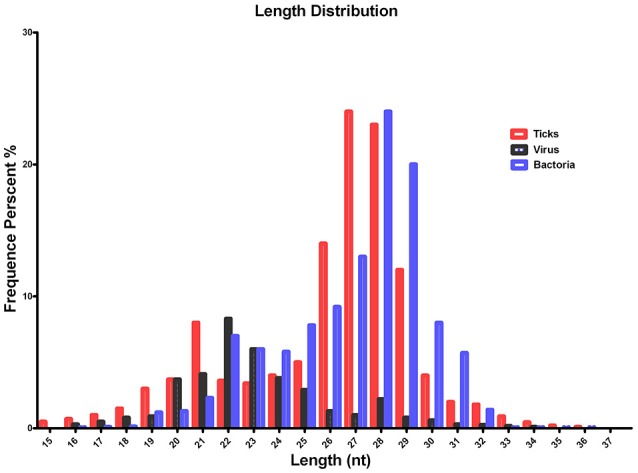
Summary of the tag length distribution following the sequencing and annotation of small RNA from Hyalomma rufipes. The length of the small RNAs varied between 18 and 30 nt. Length distribution analysis is helpful when elucidating the composition of small RNA samples. For example, miRNA is normally 21 or 22 nt, siRNA is 24 nt, and piRNA is 30 nt. The x-axis represents the length of the small RNAs. The y-axis represents the percentage frequency of small RNAs of specific lengths among the sequencing reads. Red indicates the length distribution of total clean reads from ticks and the first peak generated by the Dicer enzyme; the second peak was generated by the Piwi enzyme. Black indicates the length distribution of SCRV. The peak was mediated by Dicer activity. Blue indicates the length distribution produced by Dicer and Piwi from the bacteria communities. Nt indicates nucleotides.